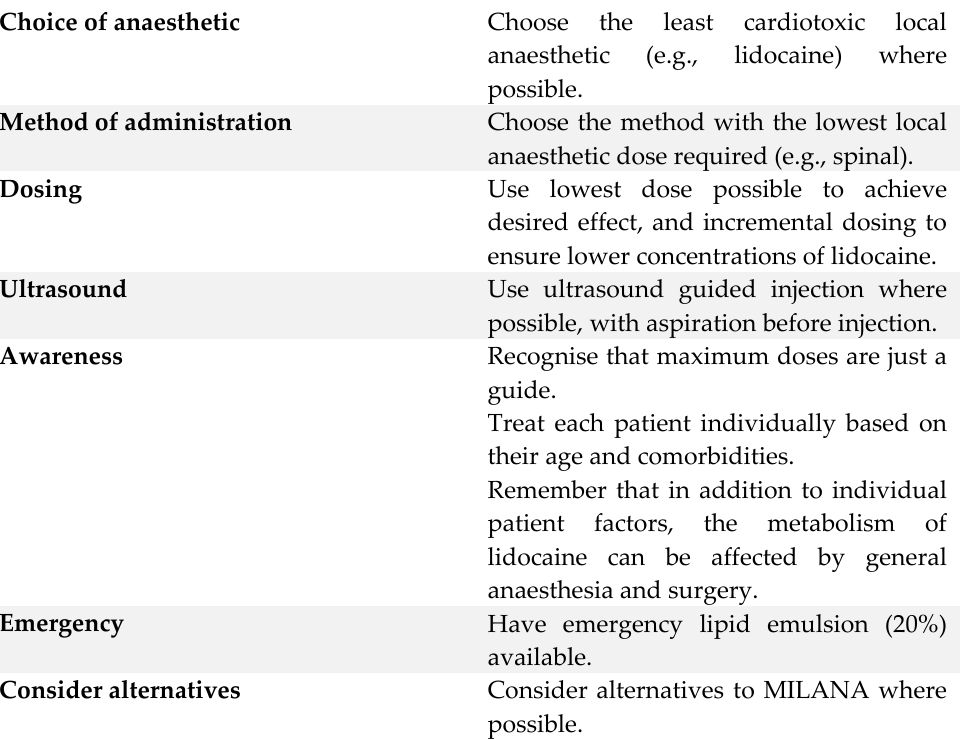
Figure 5. Strategies to minimise local anaesthetic systemic toxicity (LAST) [86].